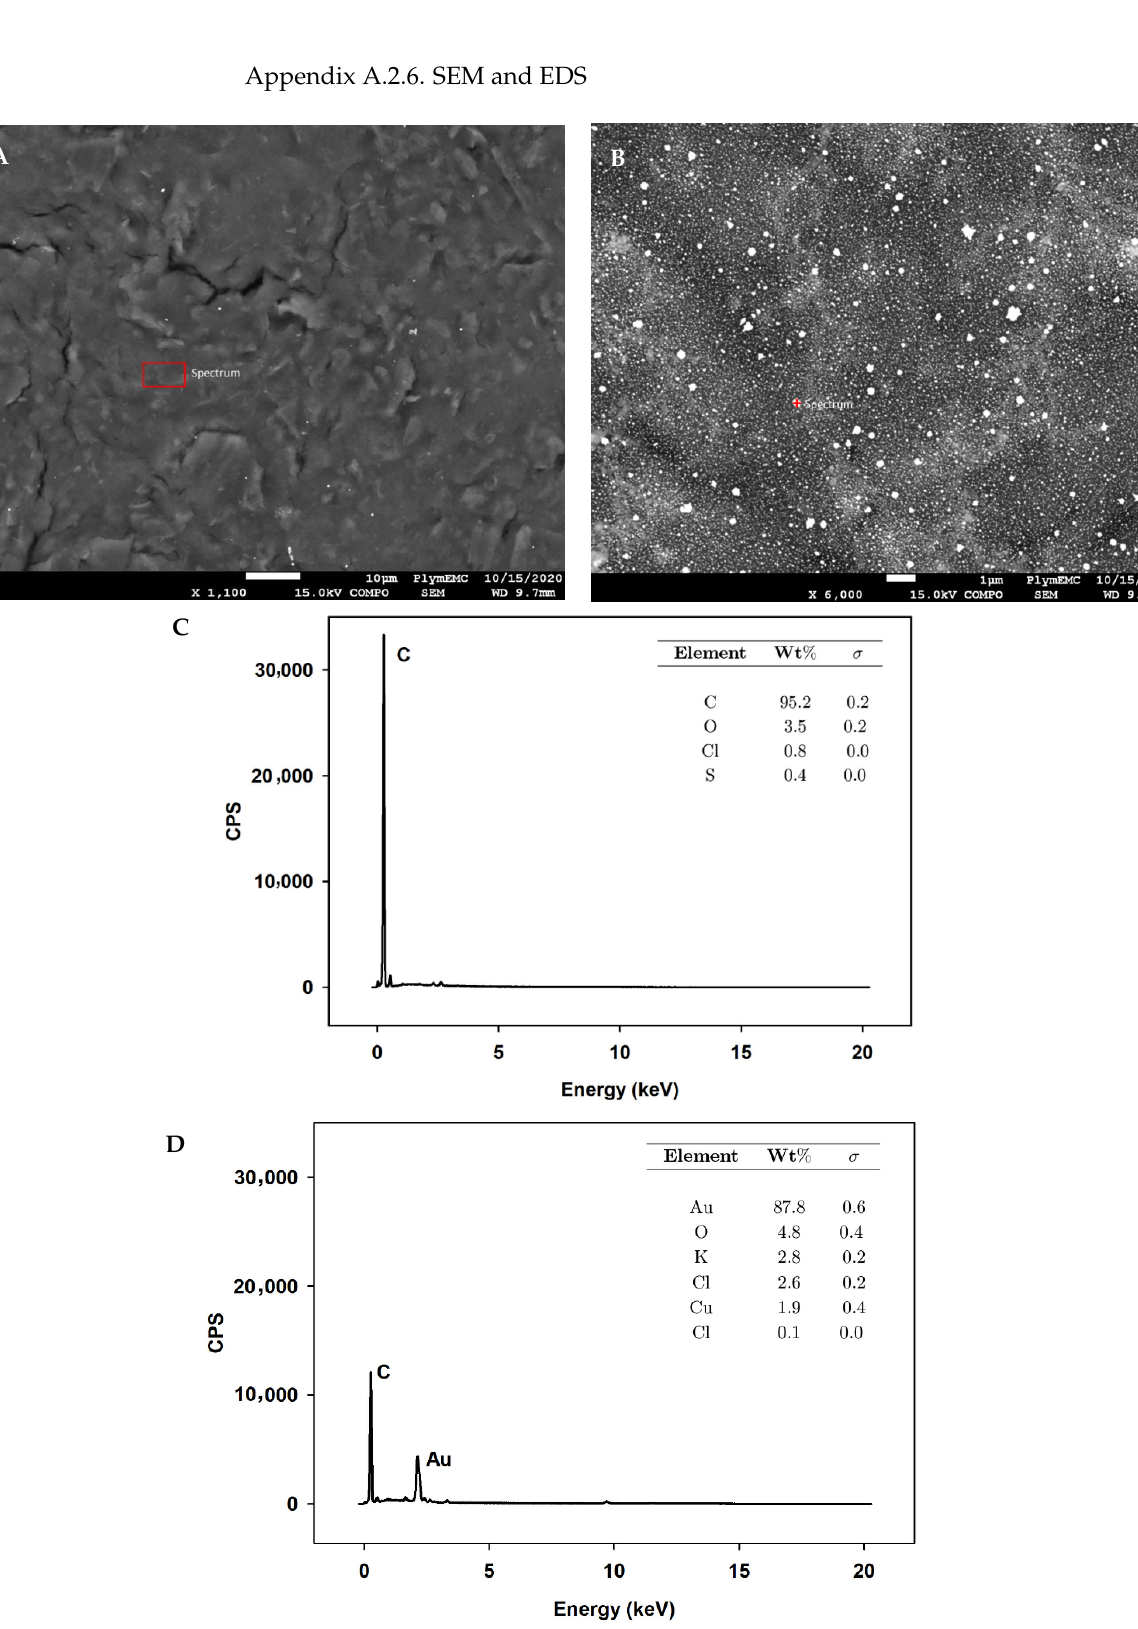
Figure A6. SEM images of ErGO ( A ) and ErGO/AuNPs ( B ) electrodes. EDS spectra of the ErGO ( C ) and ErGO/AuNPs ( D ) electrodes. The inset tables show the present elements, the relative concentration (Wt%) of each element, and their measurement errors ( σ